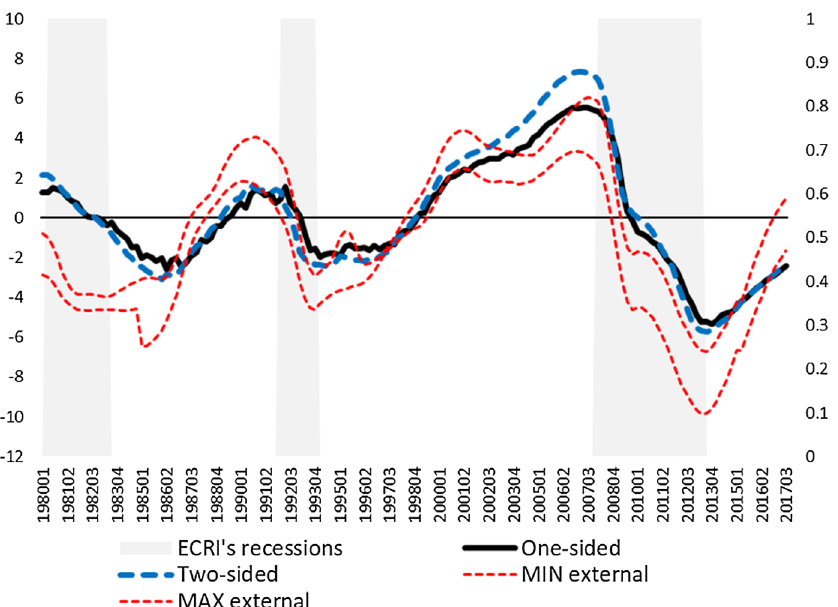
Fig. 5 Spanish output gap, multivariate estimate. Source of data : author’s